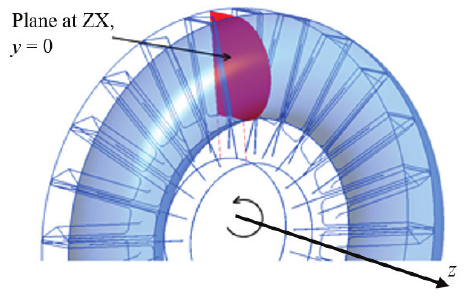
Figure 13. Plane Figure 13. Plane zx.